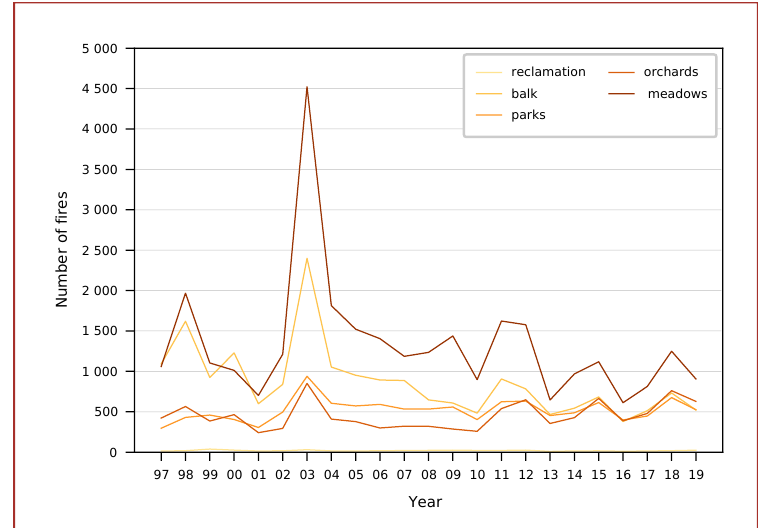
Figure 11. Various kinds of other wildland fires in the Czech